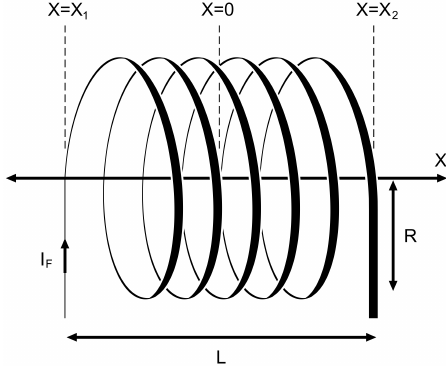
Figure 2. Approximating the sense winding as a finite solenoid of length L and radius R . Table 1. Properties of the materials used in the